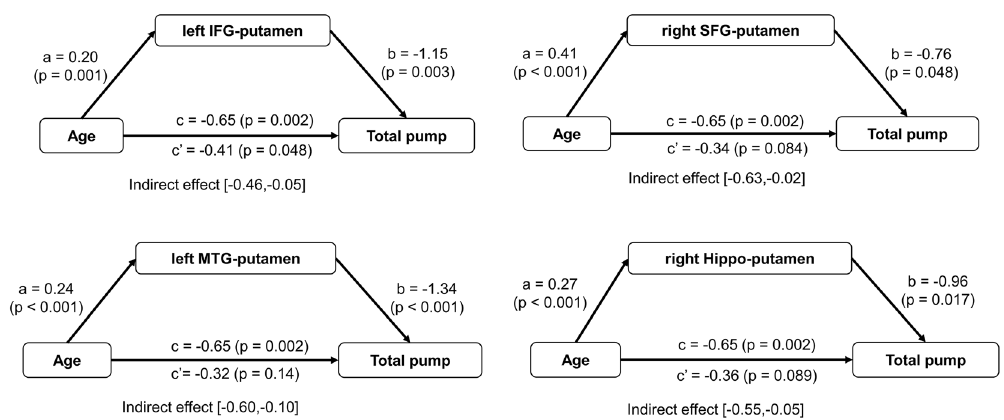
Figure 4. Age-effect on risk behaviors mediated by the putamen network. Mediation analyses showed that age influenced adjusted number of pumps mainly through the fronto-putamen and temporal-putamen